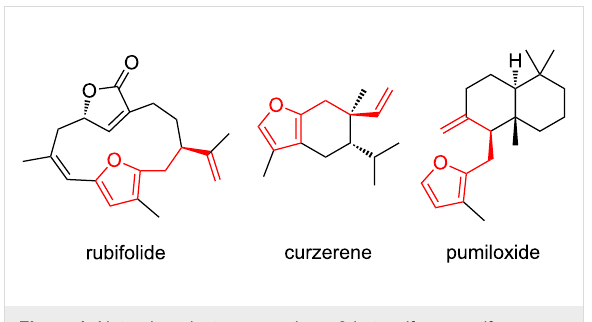
Figure 1: Natural products possessing a 2-butenylfuran